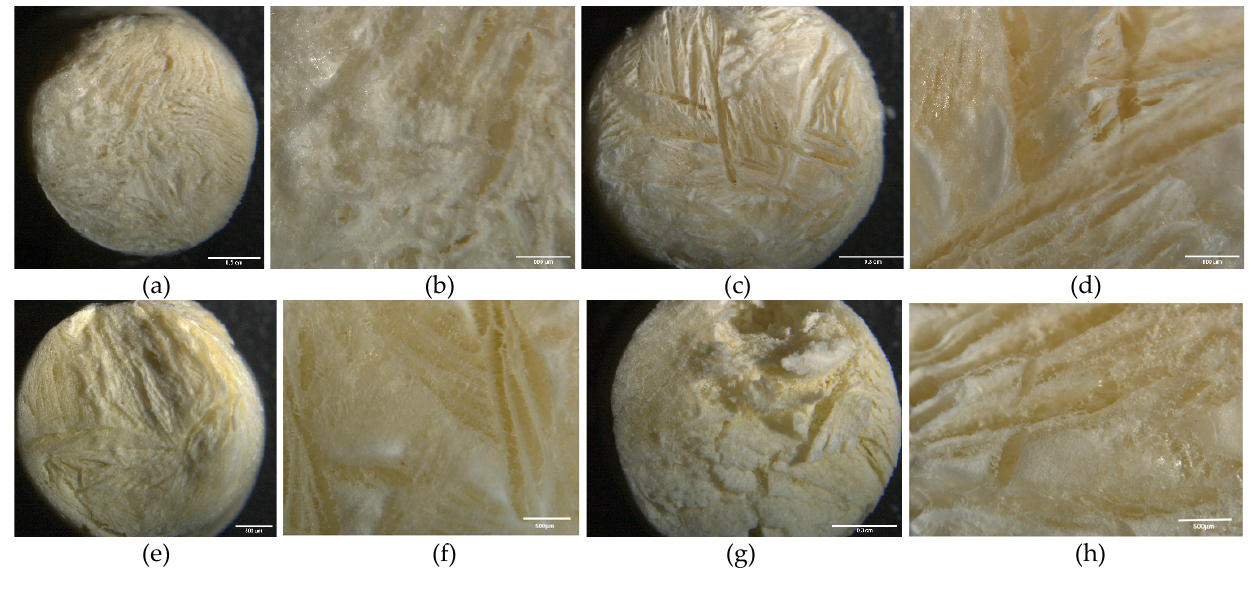
Figure 10. Surface morphology of plant extract-loaded hydrogel through a stereoscope with ( a ) EG − methanolic/NRC (M = 1.25), ( b ) EG − methanolic/NRC (M = 4), ( c ) EG − methanolic/MCC (M = 1.25), ( d ) EG − methanolic/MCC (M = 4), ( e ) EG − ethanolic/NRC (M = 1.25), ( f ) EG − ethanolic/NRC (M = 4), ( g ) EG − ethanolic/MCC (M = 1.25), ( h ) EG − ethanolic/MCC (M = 4).